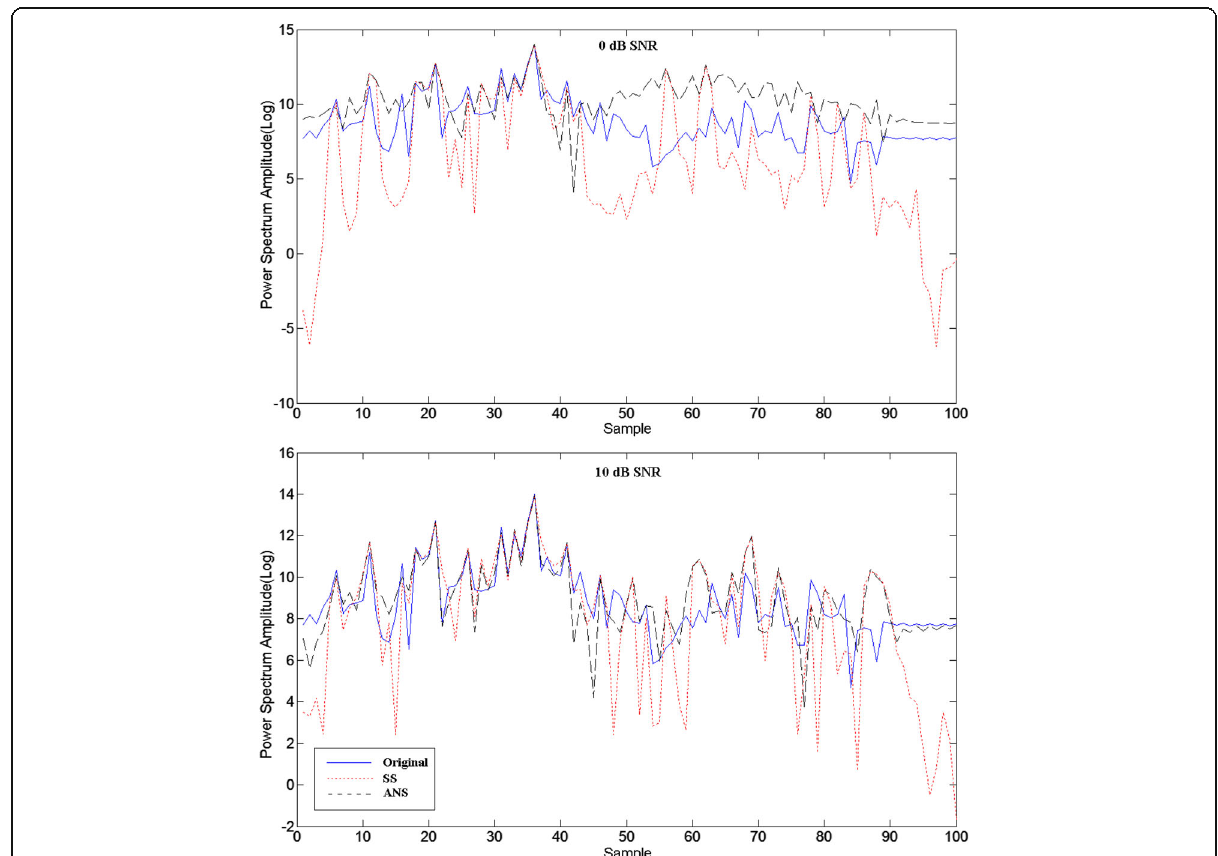
Fig. 4 Log power spectrum of a speech frame of ‘ FAK_1B.08 ’ utterance from test set A of Aurora 2 task contaminated with subway noise at 0 and 10 dB SNRs in logarithmic